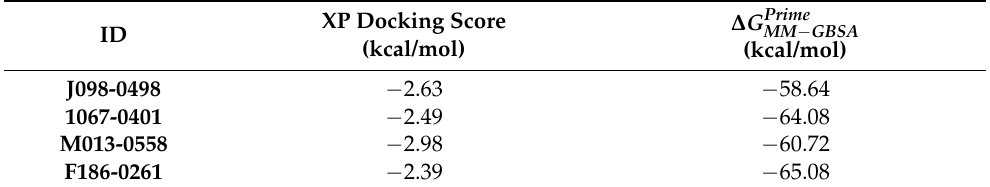
Table 7. XP docking scores of the identified hits to NusB, and their corresponding binding free energy calculated by Prime MM-GBSA module in Maestro 10.2.